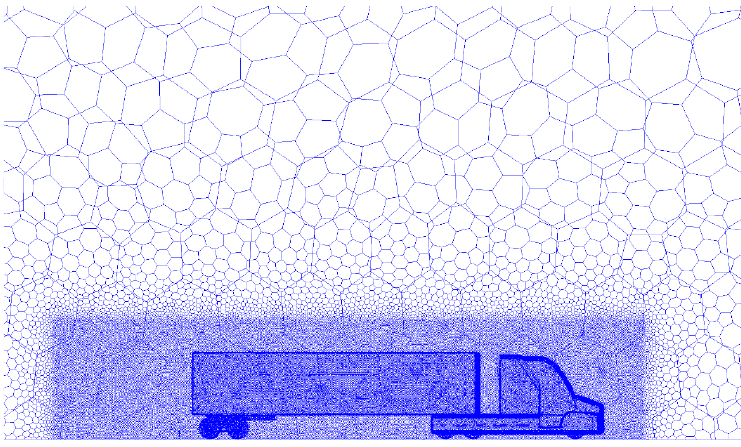
Fig. 3. Mesh refinement box around the